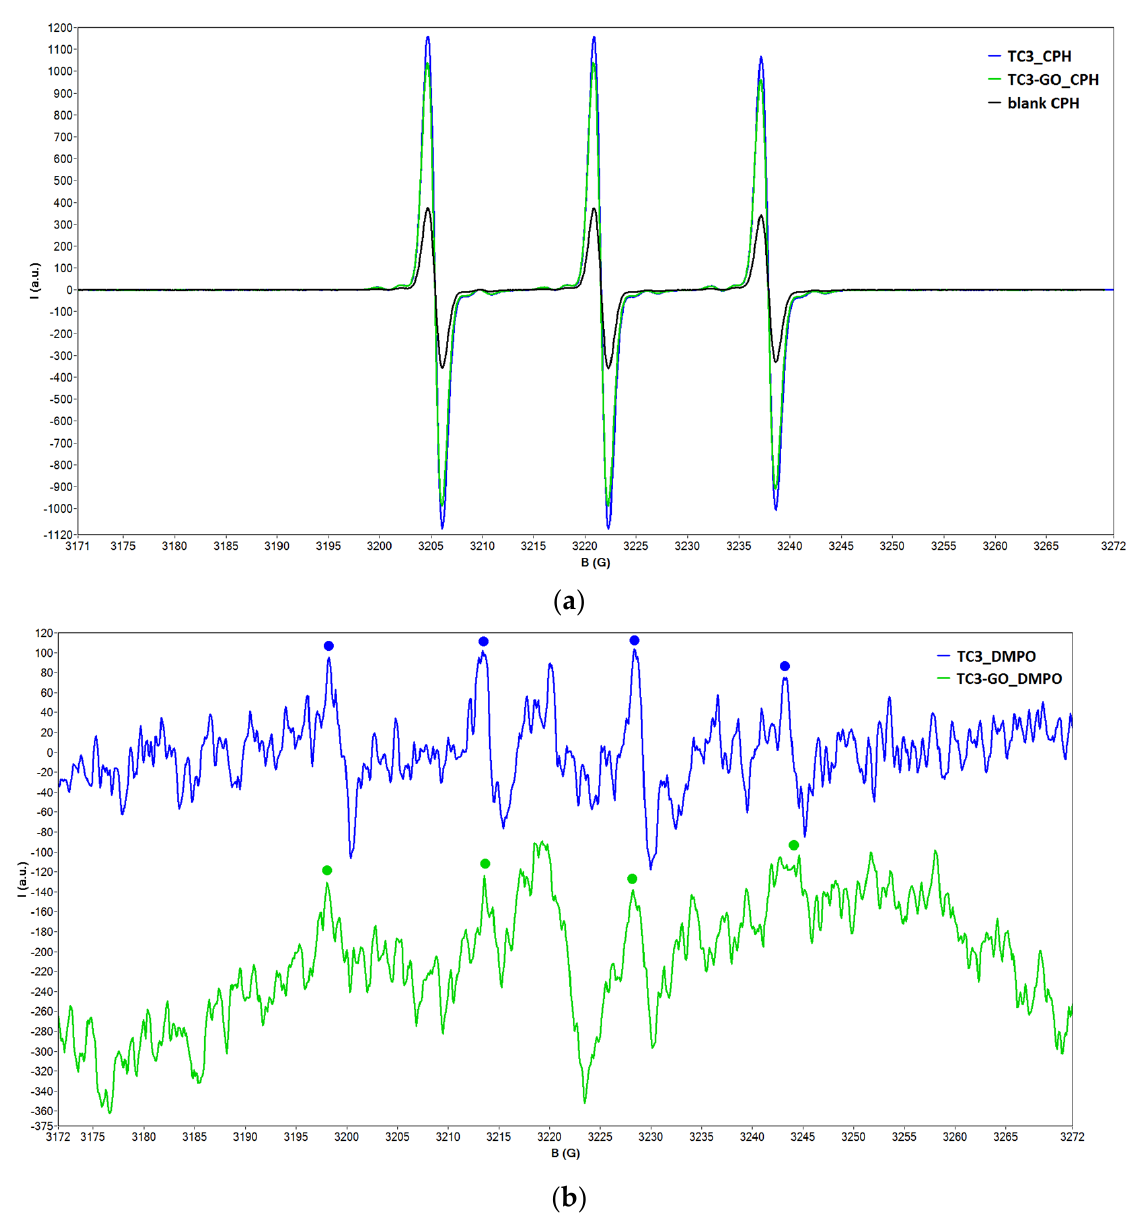
Figure 3. The EPR spectra of the TC3 and TC3-GO samples in the presence of ( a ) CPH and ( b )